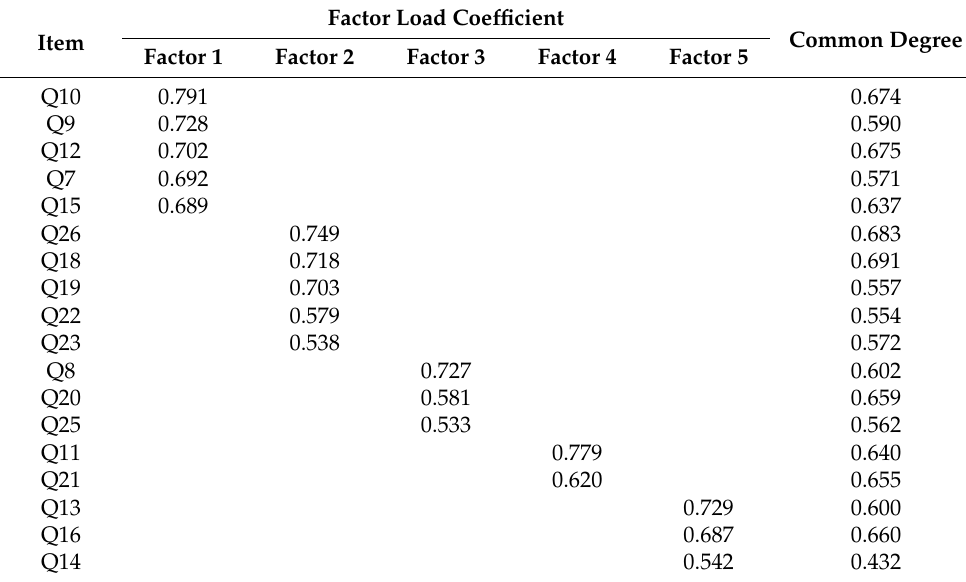
Table 4. Factor load coefficient after rotation.